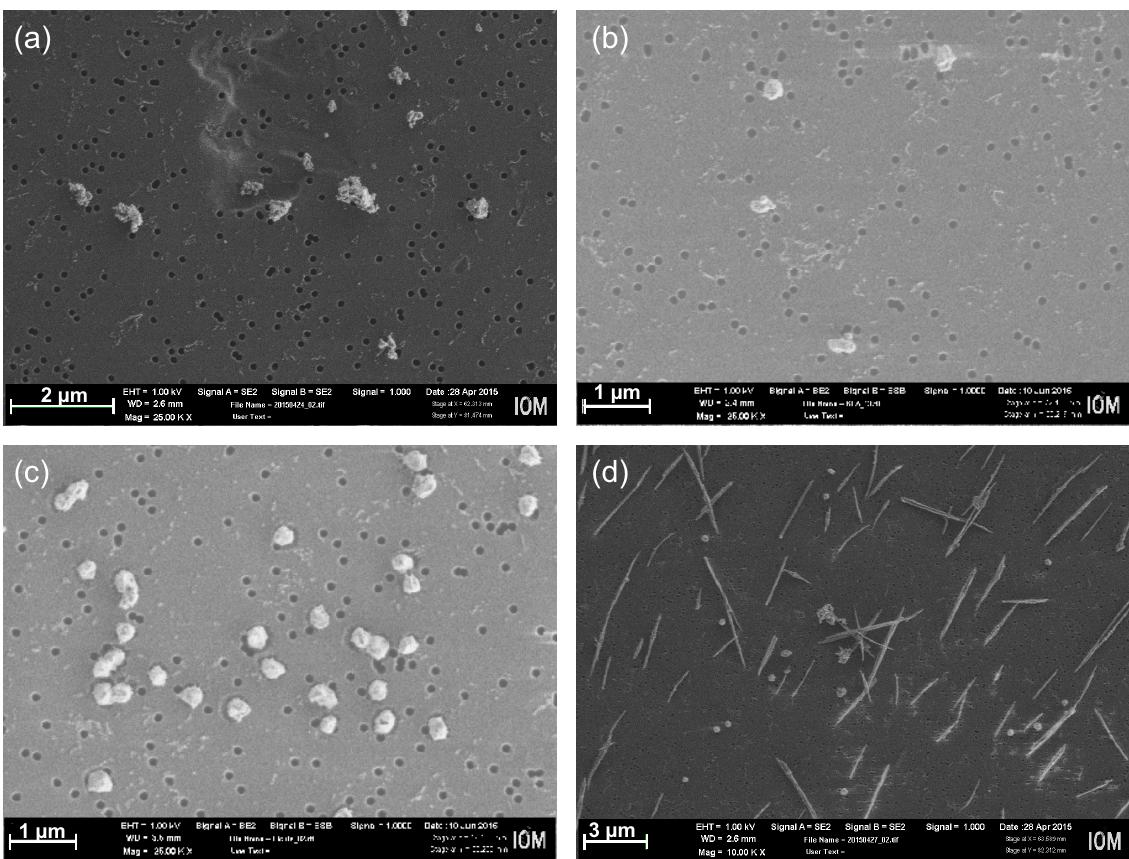
Figure 3. Scanning electron microscope (SEM) images of (a) bottom ash particles from brown coal burning (dry generation), (b) fly ash particles from brown coal burning (dry generation), (c) bottom ash particles from spruce burning (wet generation), and (d) fly ash particles from brown coal burning (wet generation). In each case particles with D p,el = 300nm were selected. Note the different